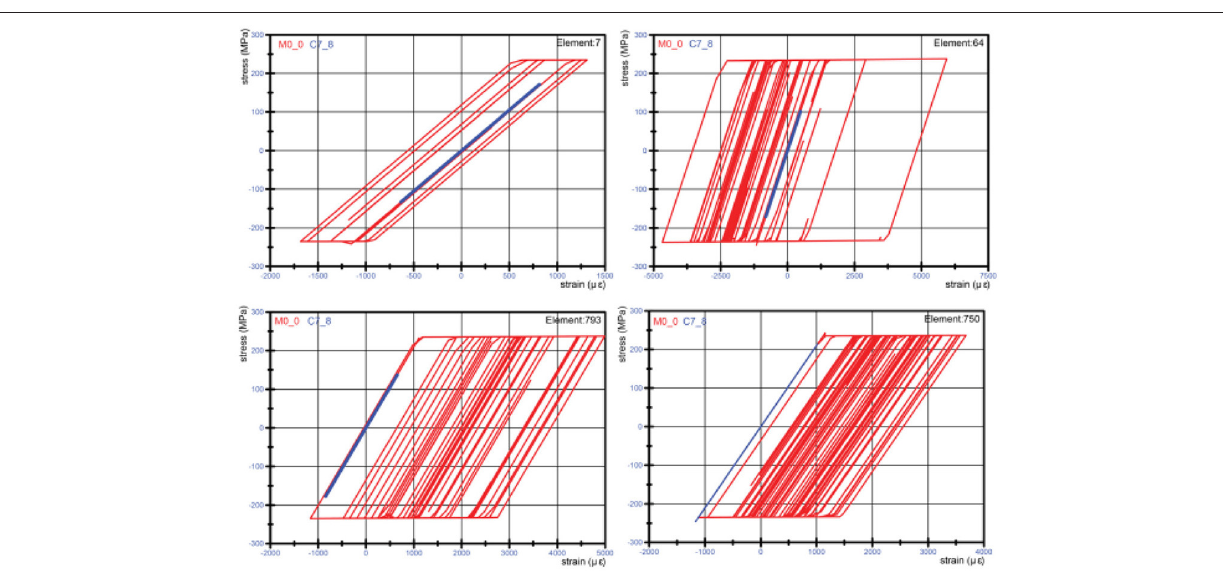
Frontiers in Built Environment |